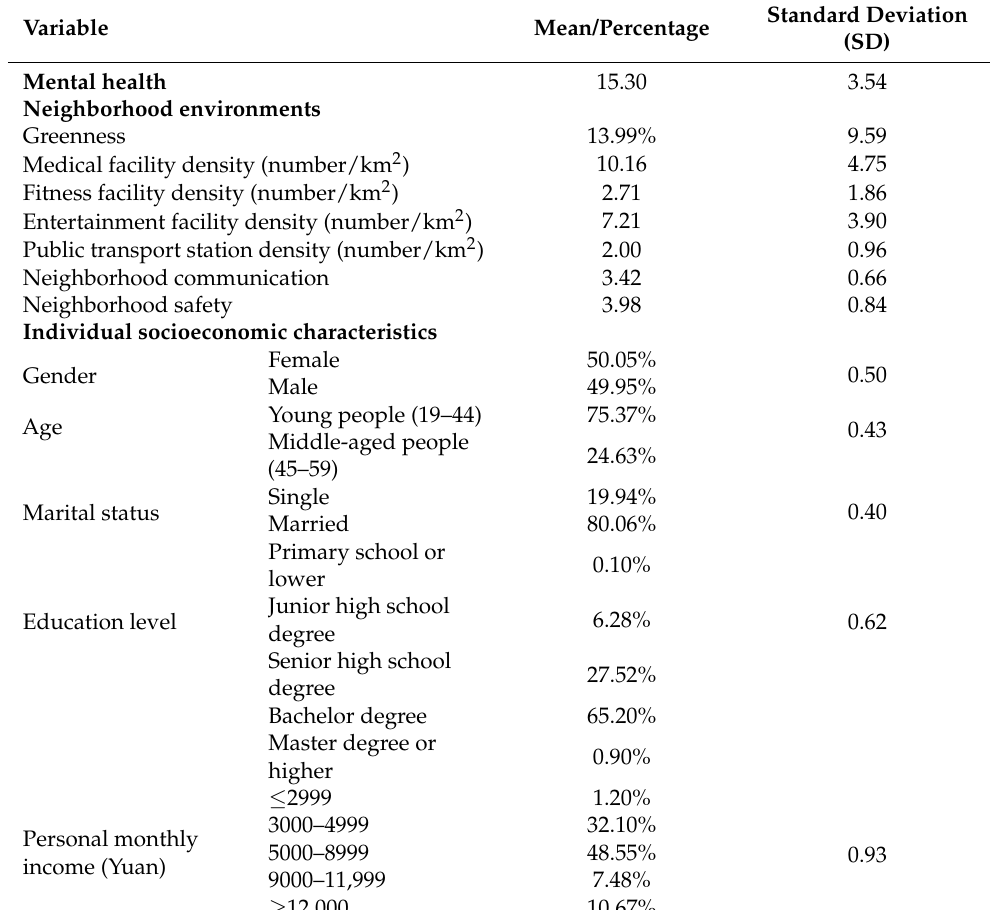
Table 1. Descriptive statistics for all variables (N =